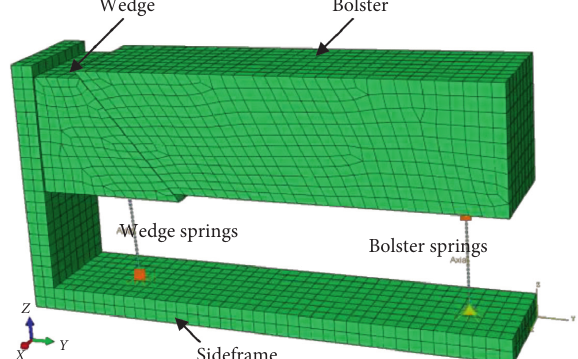
Figure 7: Quarter bogie model.